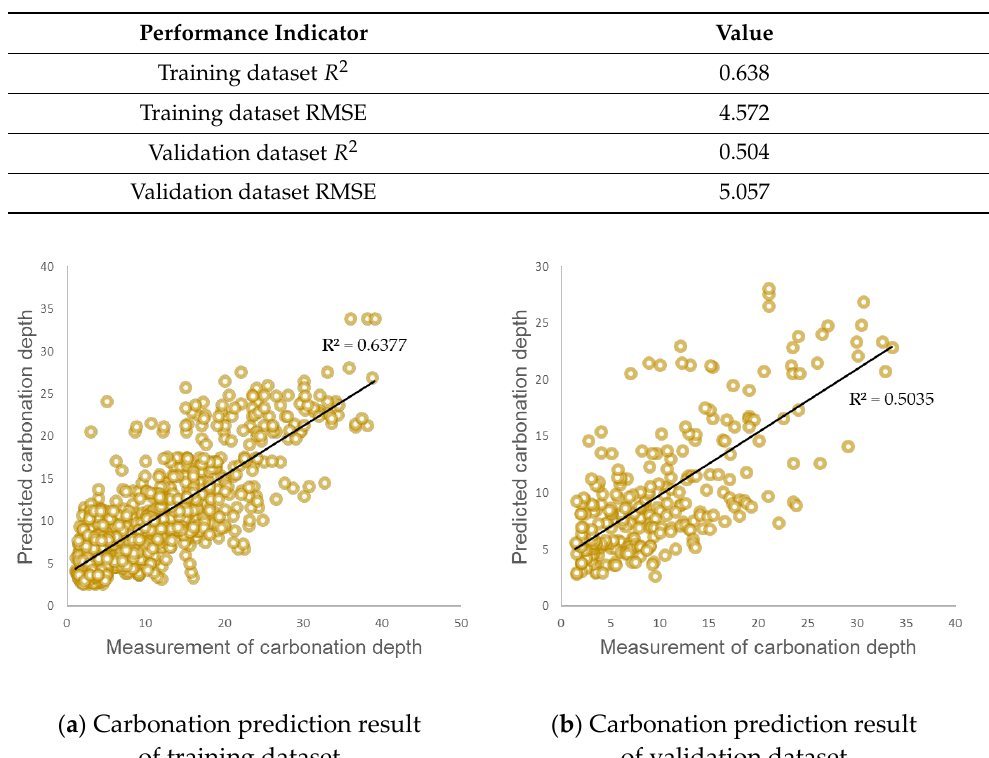
Table 5. Performance indicators of the carbonation model.